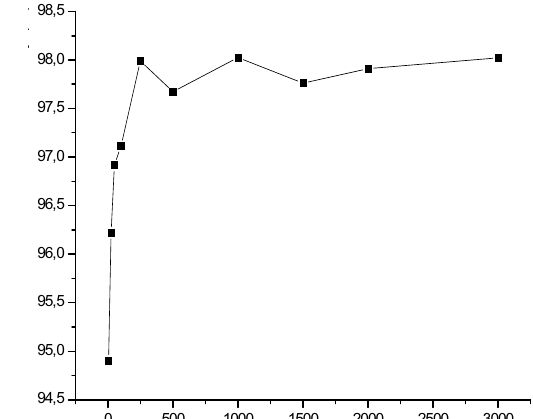
(Figs. 3.1-3.4), which show different dependencies obtained in experiments.